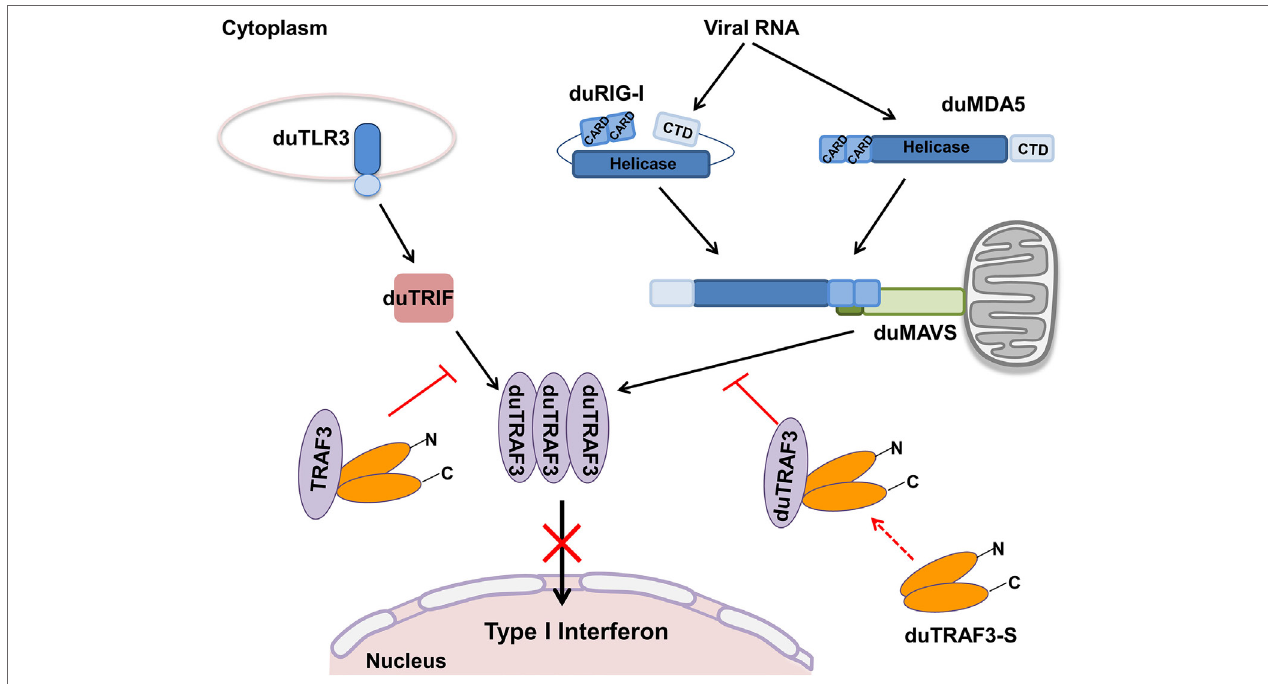
FigUre 9 | Model for regulation of type I interferon signaling pathway by duck TRAF3s (duTRAF3s) in duck cells. In duck RIG-I-like receptors, signaling pathway, after duRIG-I/duMDA5 recognizes pathogen-associated molecular patterns (PAMPs), results in the recruitment of duMAVS, which in turn recruits duTRAF3 homotrimers and then induces the activation of type I interferon response; following recognition of PAMPs, duTLR3 interacts with duTRIF, and then duTRIF recruits homotrimeric duTRAF3 proteins to activate type I interferon promoter. Spliced isoform of duTRAF3 (duTRAF3-S) interacts with duTRAF3, which impairs the homotrimeric structural of duTRAF3. The formation of duTRAF3–duTRAF3-S hetero-oligomerization blocks the interaction between duTRAF3 and duMAVS or duTRIF and then attenuates the activation of type I interferon